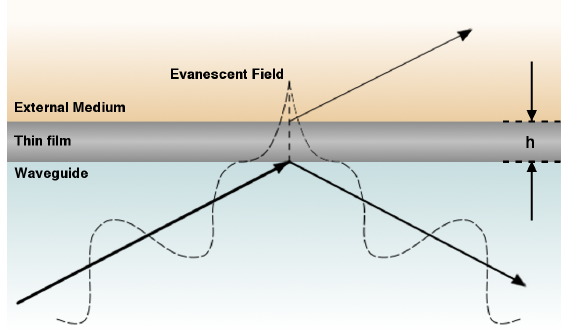
Figure 2. When a beam of light undergoes total internal reflection, as occurs within optical waveguides, the incident electromagnetic energy slightly protrudes out into the external media at each reflection point; if the cladding layer is sufficiently thin, the light may optically tunnel through the film, resulting in a beam of light within the external medium whose intensity is proportional to the film thickness